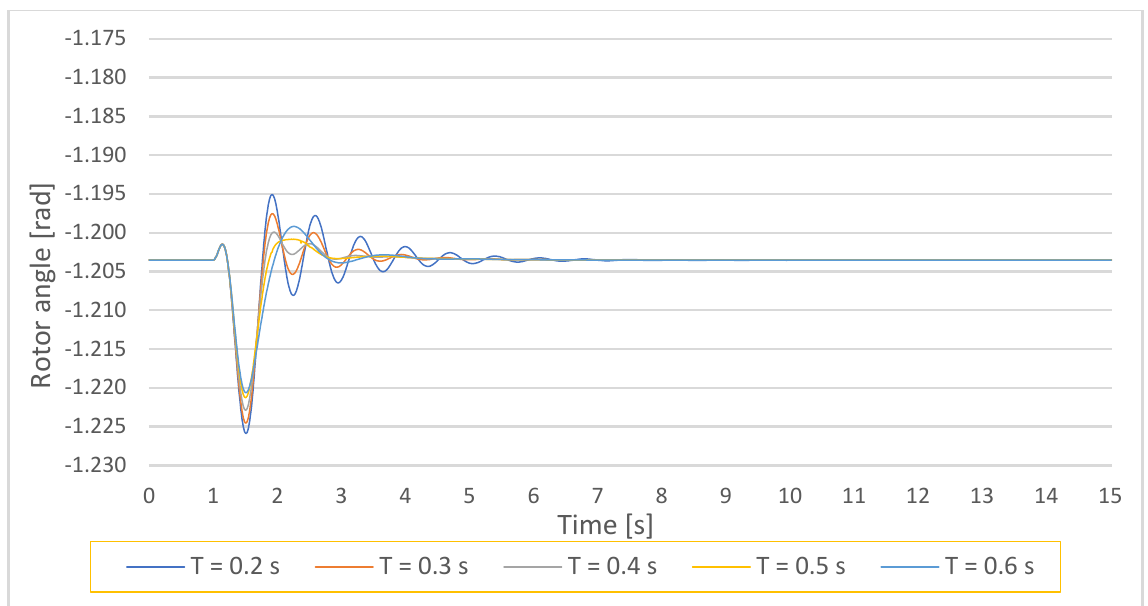
Figure 7. Gen1 rotor angle response on a small disturbance with PSS parameters K = 10, and T = Ti, 1 = 0.2 s – 0.6 s.